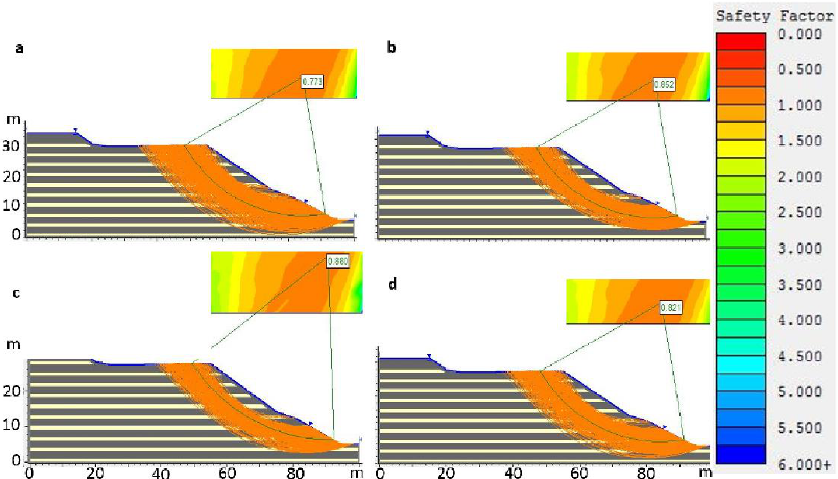
Figure 13. The graph shows all possible circular failure surfaces with a safety factor of less than one in orange; look at the vertical scale on the right and the most critical of all is marked in green. Numerical modeling of the stability factors based on the reconstruction of the topography conditions before the failure (back-analysis), considering static scenarios, with the hydraulic head set at the surface. ( a ) Janbu Method, ( b ) simplified Bishop Method, ( c ) GLE/Morgenstern–Price Method and ( d ) Janbu corrected Method.